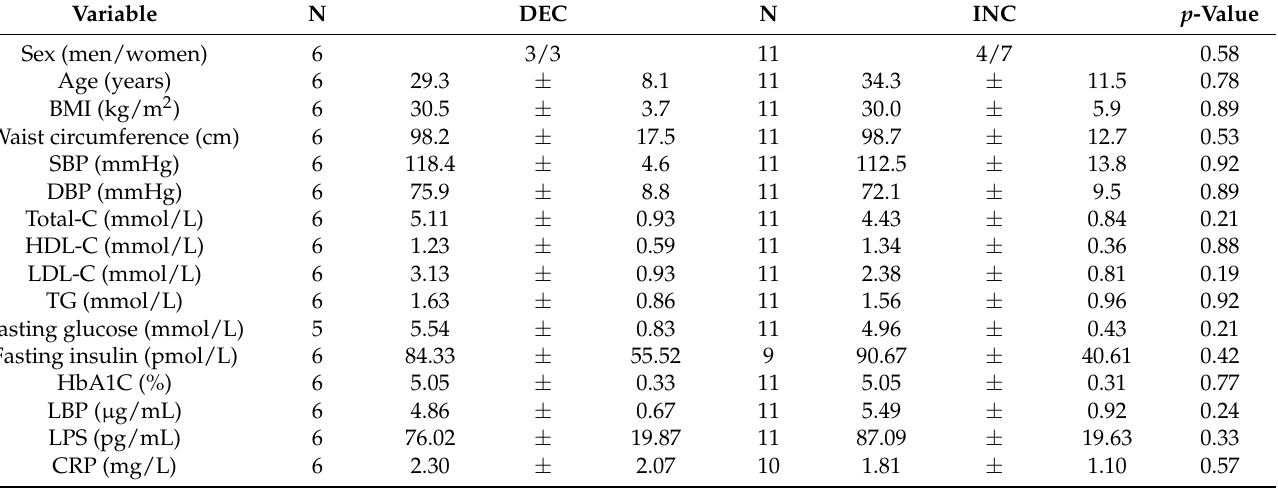
Table 1. Clinical characteristics of study participants at week 0 according to TMAO subgroups.